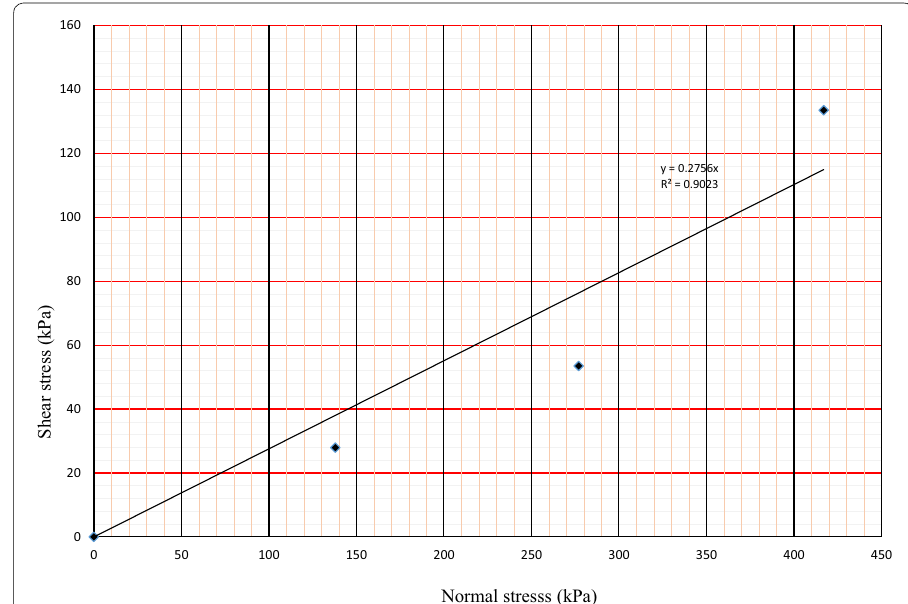
Fig. 4 Shear stress versus normal stress plot, soil to soil using conventional approach for sample 2